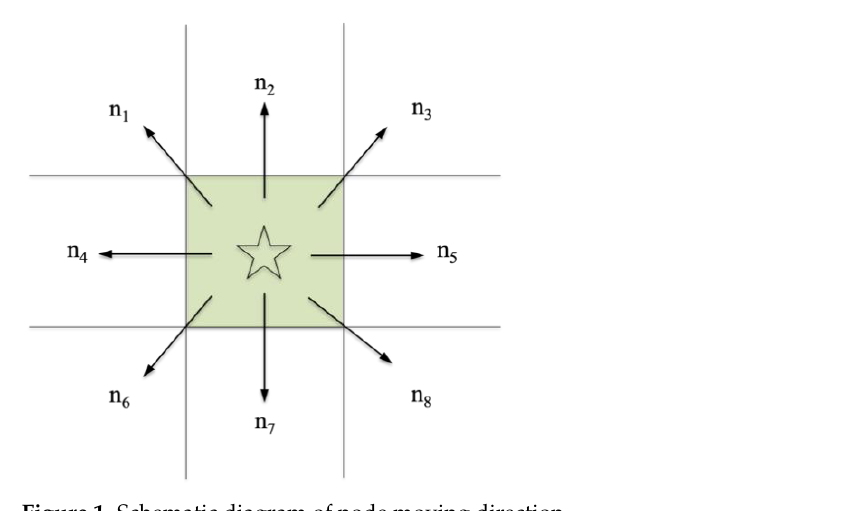
Figure 1. Schematic diagram of node moving direction.